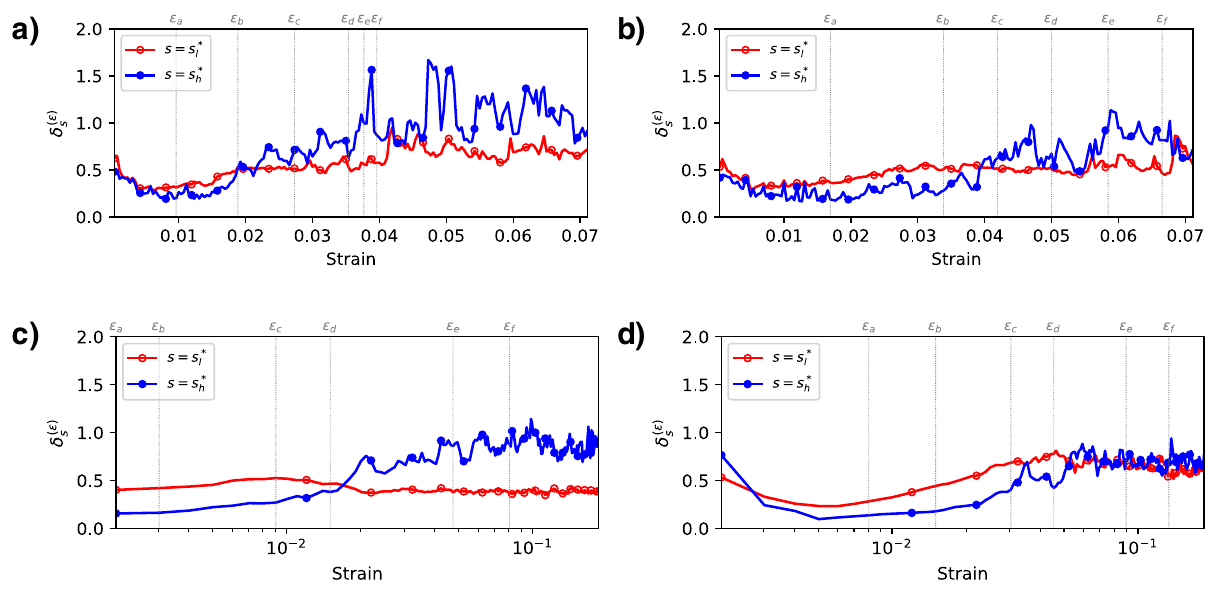
Figure 6. The evolution in the strength of microband-like ( s = s ∗ l ) and shearband-like ( s = s ∗ h ) s -LID patterns measured in contrast for systems ( a ) 5K, ( b ) 5K-SR, ( c ) 20K, and ( d ) 20K-NR. Note strains in samples 20K and 20K-NR are shown in log scale for ease of presentation. s ∗ l is set to 100 for sample 20K-NR, the same as sample 20K, since rotation is completely suspended and no actual s ∗ l can be